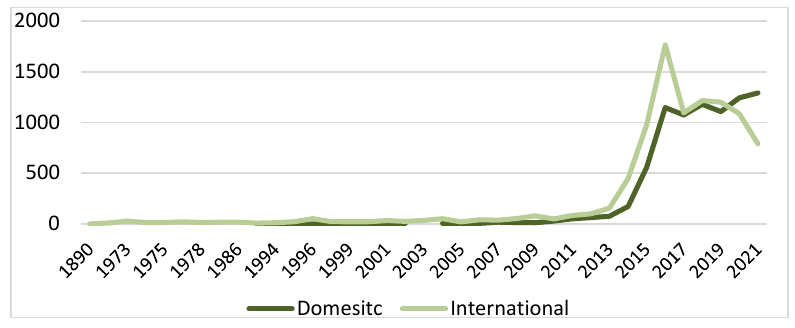
Figure 1. Trend of patent applications for self-balancing vehicles. Table 1. Number of different patent types of self-balancing vehicles at home and abroad.